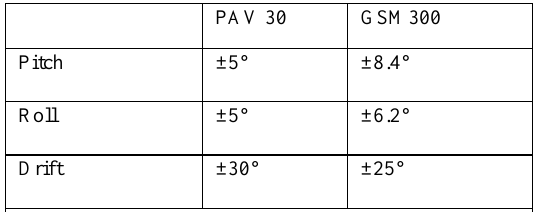
Table 1: Limits of PAV30 and GSM3000 for adjusting rotations